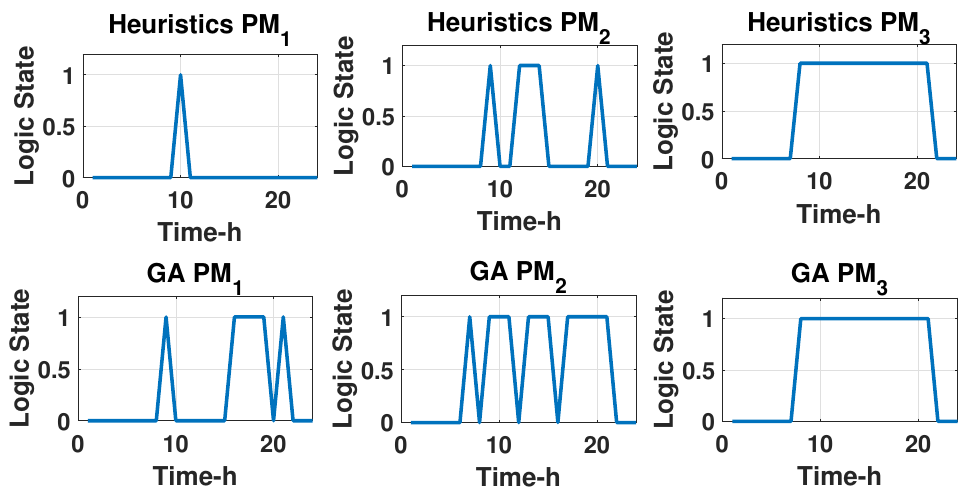
Figure 10. Heuristics and GA water pumps numerical